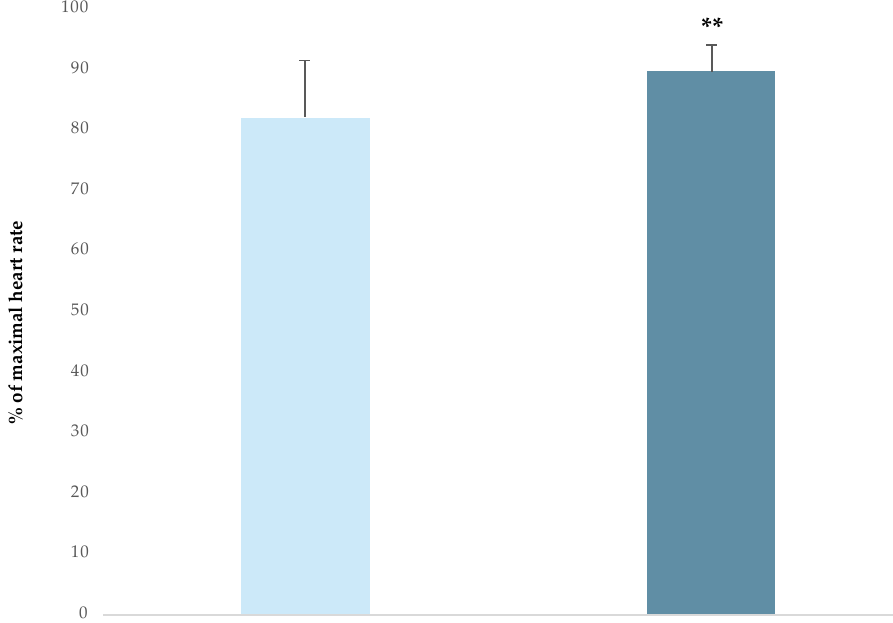
Figure 6. Heart rate responses according to the gender. The magnitude of the standardised differences (effect size) between the competition level and gender is indicated by the number of symbols: two for a large difference.